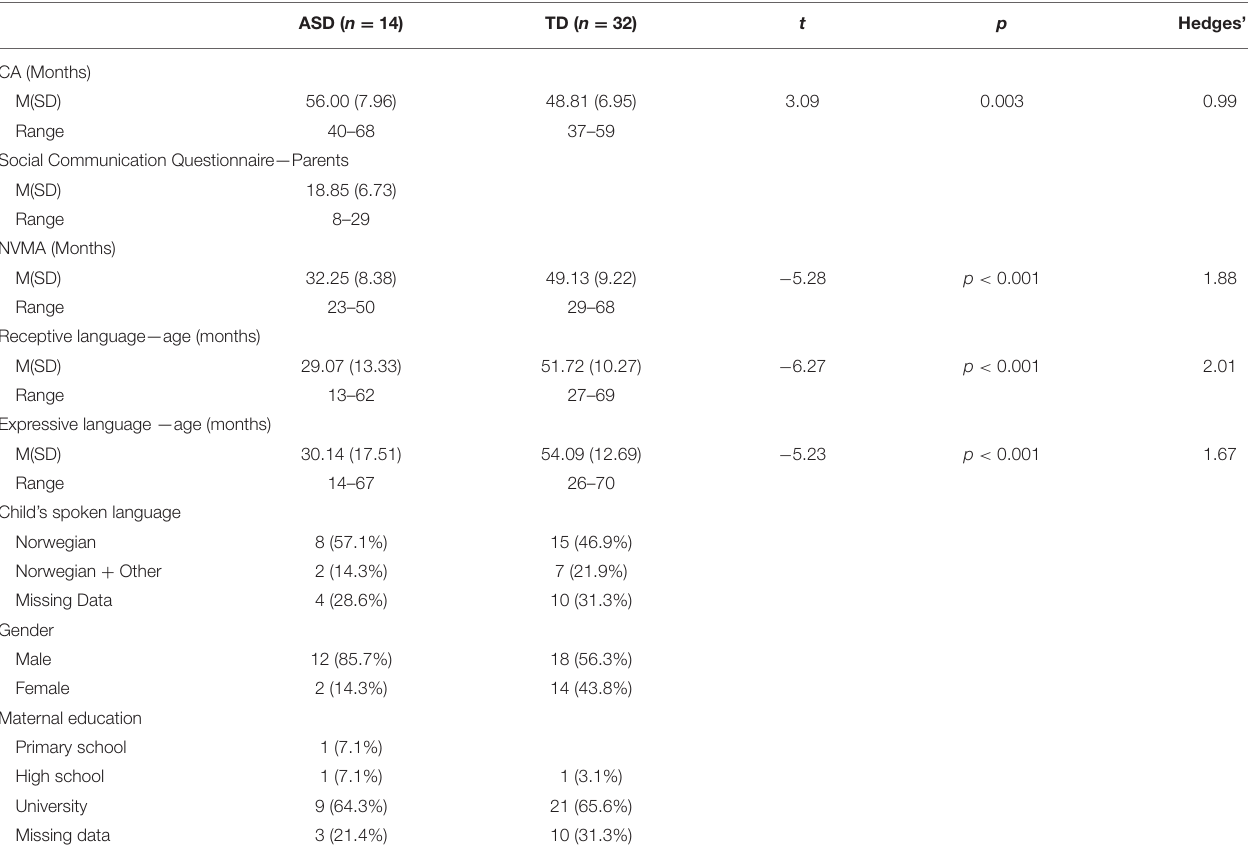
TABLE 1 | Descriptive statistics of typically developing and autism spectrum disorder